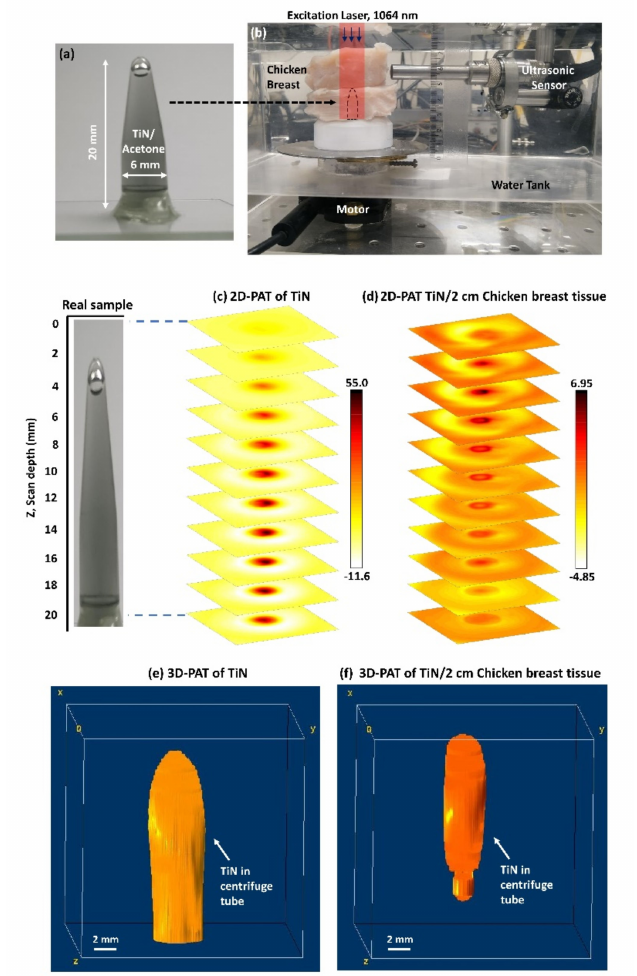
Figure 14. ( a ) Real picture of TiN/acetone sample filled inside a centrifuge tube (length = 20 mm, OD = 6 mm), ( b ) 3D-PAT setup containing TiN sample covered with 2 cm of chicken breast tissue. The PAT is performed for both bare TiN and TiN with chicken under 5 ns, 10 Hz, 1064 nm excitation where the peak energy density on the sample surface is maintained to be 40 mJ/cm 2 ; depth-resolved 2D-PAT reconstructed image slices for ( c ) TiN and ( d ) TiN covered with 2 cm thick chicken breast tissue, obtained from a different scan depth. Every slice dimension is 20 mm × 20 mm; 3D-PAT reconstructed image for ( e ) TiN and ( f ) TiN covered with 2 cm thick chicken breast tissue, obtained after rendering 2D slices (from ( c , d )) in Image J software. The axes are scaled to 20 mm × 20 mm × 20